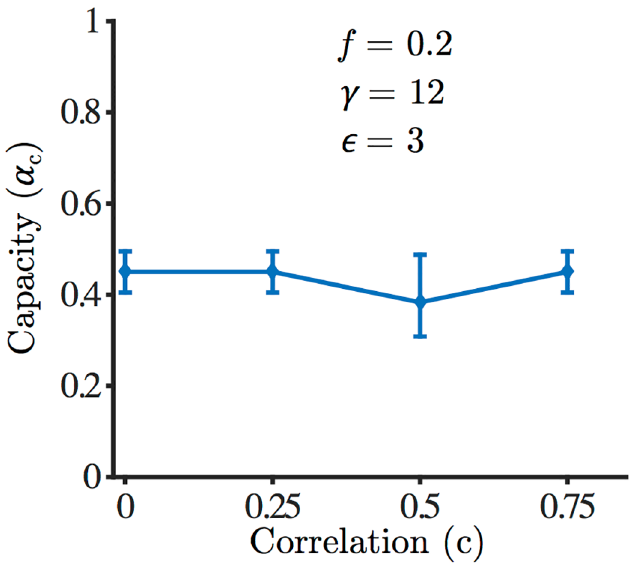
Fig 7. Capacity as a function of correlations in the input patterns, for f = 0.2 at (cid:2) = 3.0. Patterns are organized in categories, with a correlation c with the prototype of the corresponding category (see